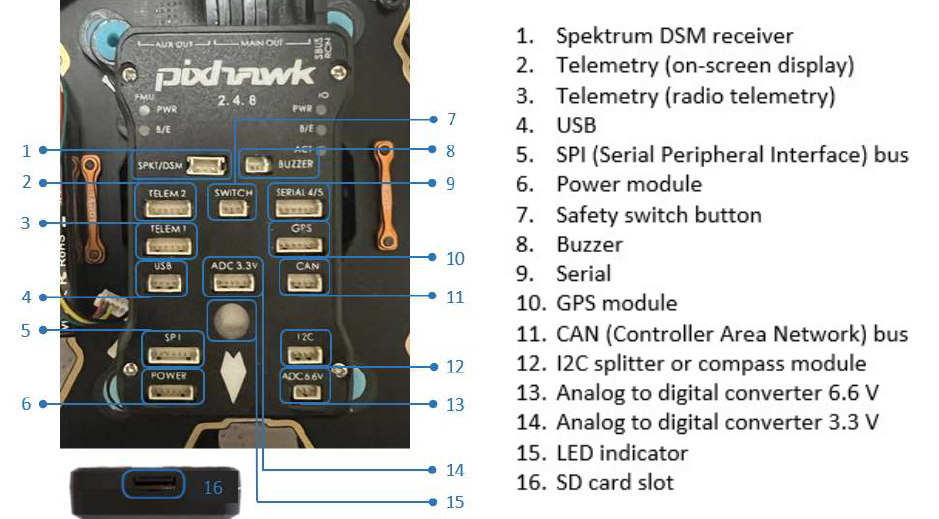
Figure 8. Video signal transmission–reception chain from hexacopter to the operator. The Pixhawk 2.4.8 flight controller (FMUv2) installed on the hexacopter v2 version, with the interfaces to various peripheral equipment, are illustrated in Figure 9.